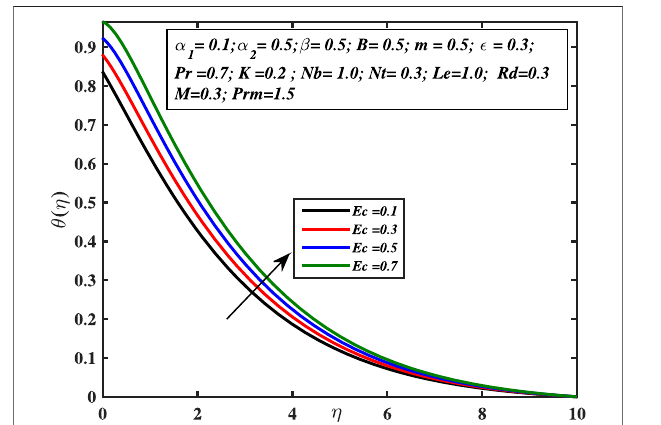
FIGURE 13 | Effect of Nb on the ϕ ( η ) pro fi le.